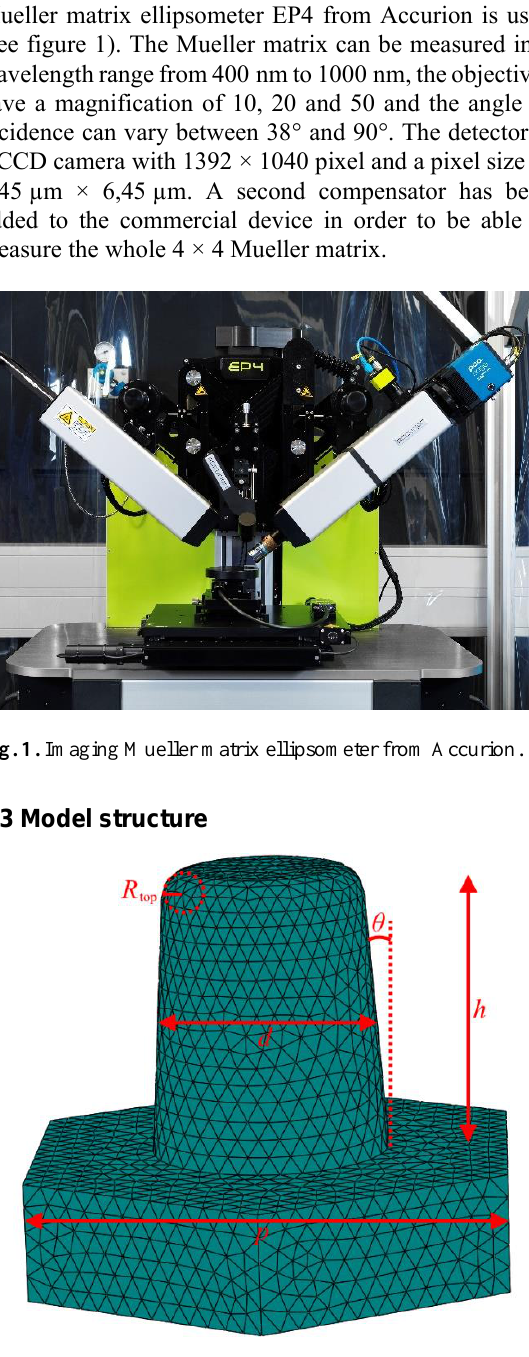
Fig. 2. Schematic layout of the used model with structure parameters: height h , pitch p , diameter at half maximum d , sidewall angle θ , top edge rounding R top .